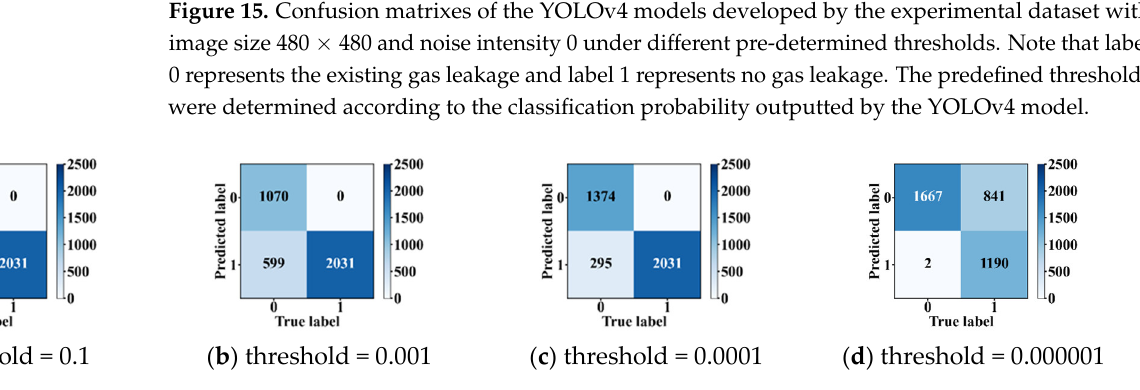
Figure 16. Confusion matrixes of the Faster R-CNN model by the experimental dataset with image size 1280 × 720 and noise intensity 0 under different pre-determined thresholds.